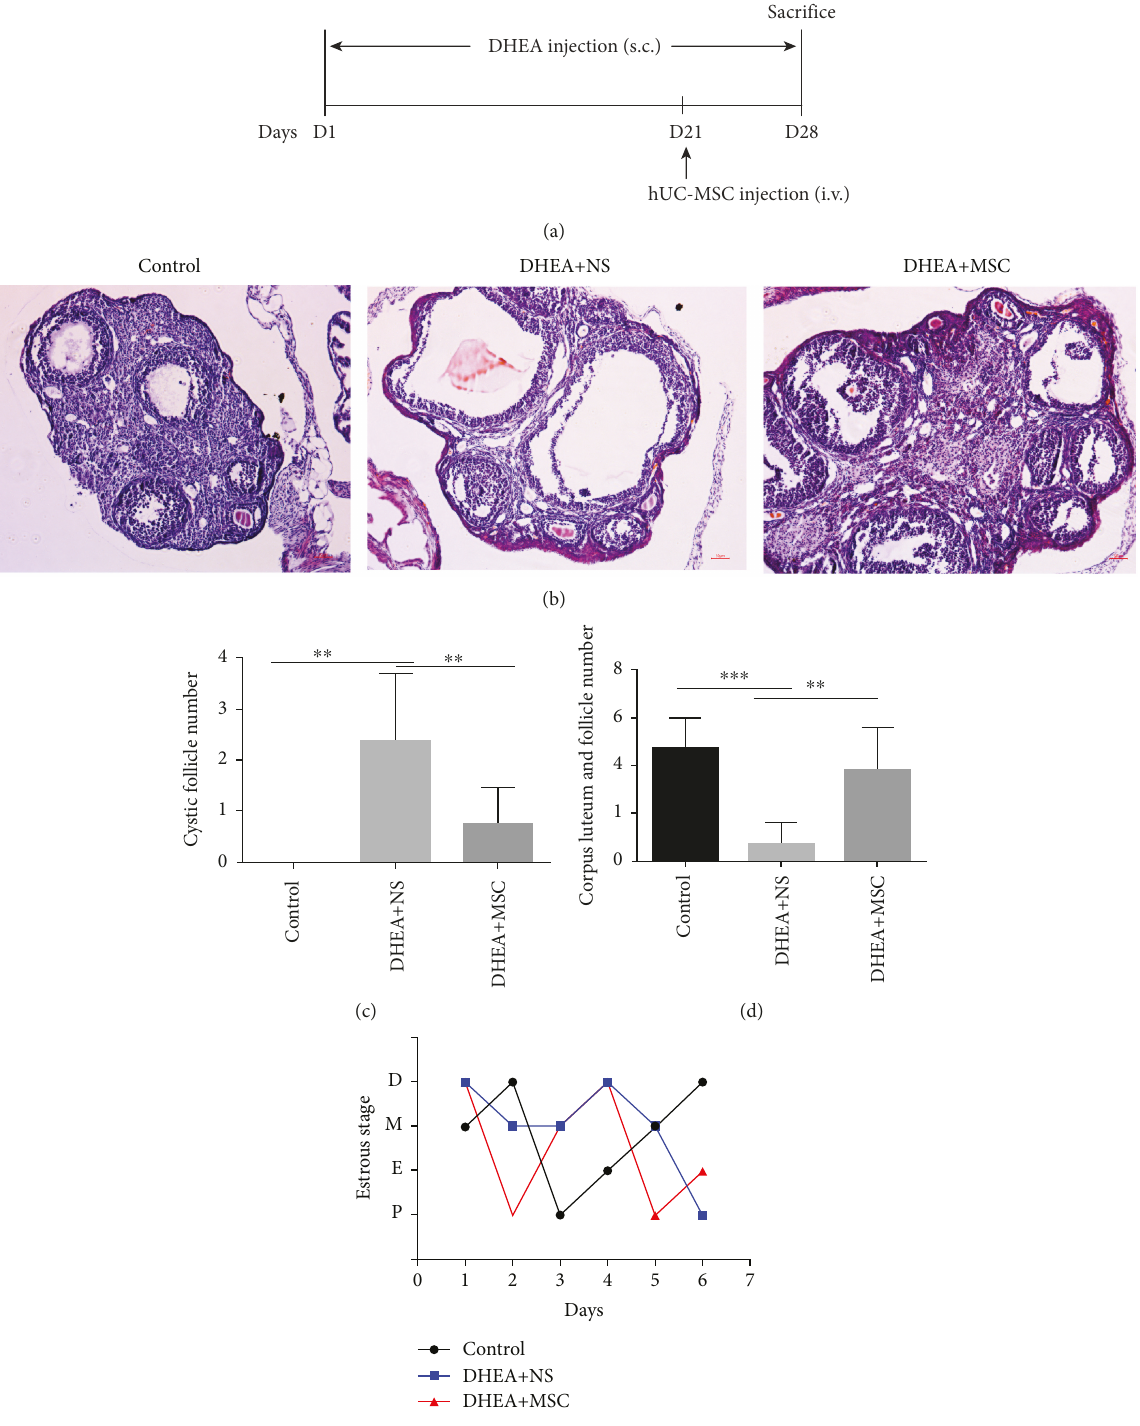
Figure 1: hUC-MSC treatment improves ovarian pathological changes and dysfunction in PCOS mice (a) Schematic of the experimental model. (b) Representative hematoxylin and eosin (H&E) staining of ovary section. Scale bars (50 μ m). (c) Numbers of cystic follicles in ovarian tissue. (d) Numbers of corpus luteum and mature follicles in ovarian tissue. (e) Representative results of estrous cycling. P: proestrus stage; E: estrus stage; M: metestrus stage; D: diestrus stage. Values are expressed as the means ± SEM . n = 8 per group. ∗ P < 0 05 and ∗∗ P < 0 01